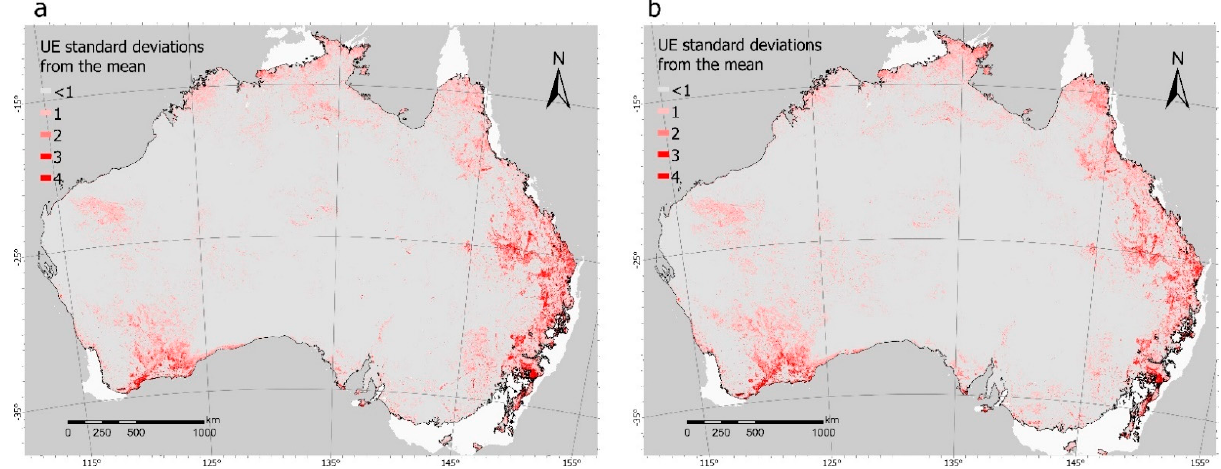
Figure 8. Images of distance to the mean unmixing error measured in standard deviations for ( a ) a wet year (2016) and ( b ) a dry year (2019).